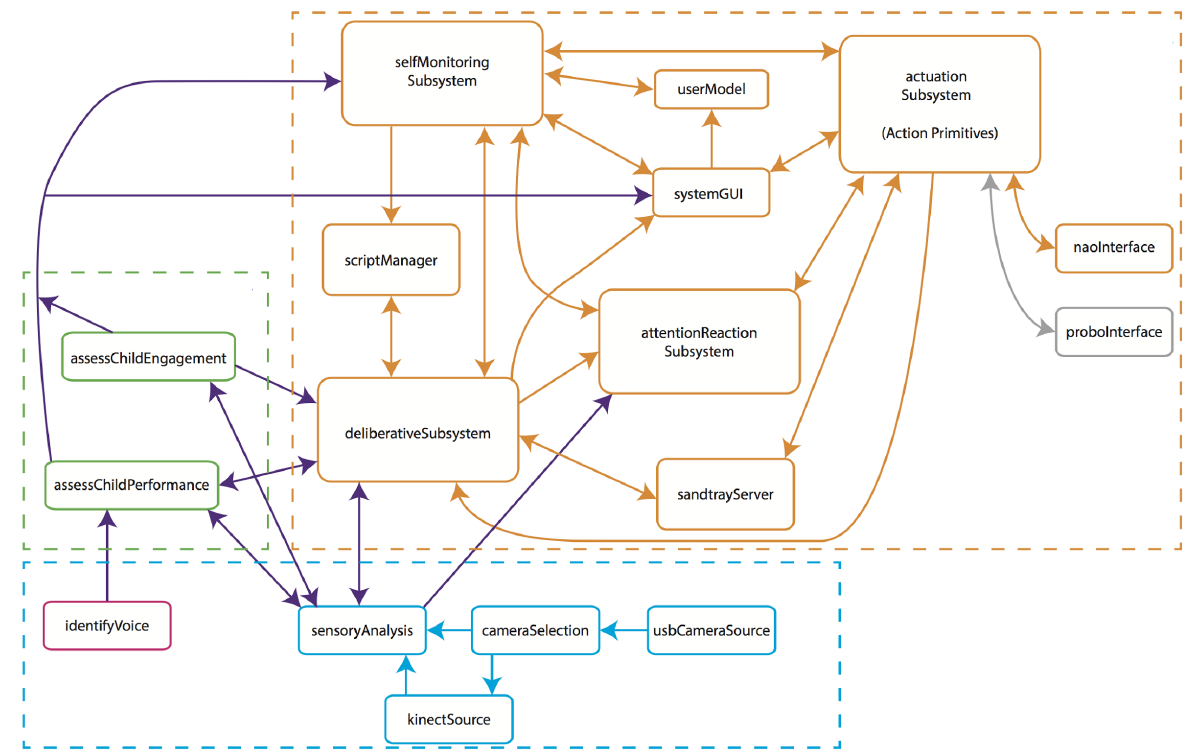
Figure 3: Graphical illustration of the DREAM software architecture. Arrows represent communication between components through one or more ports. Port names have been omitted for clarity. The three subsystems shown are: sensory interpretation (blue), child behaviour classification (green), and social cognitive controller